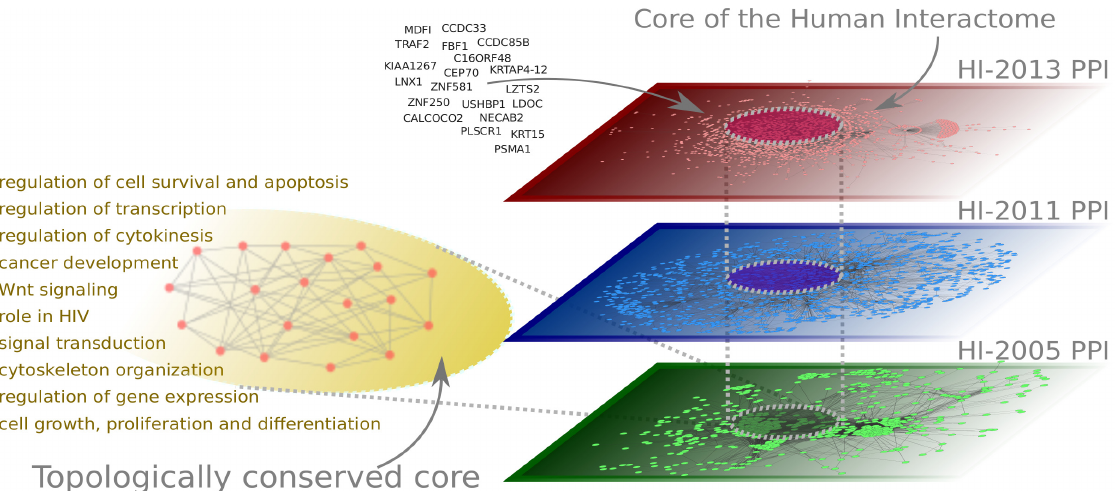
Figure 8: The core of the human interactome is conserved (i.e., remains topologically unchanged) as the interactome